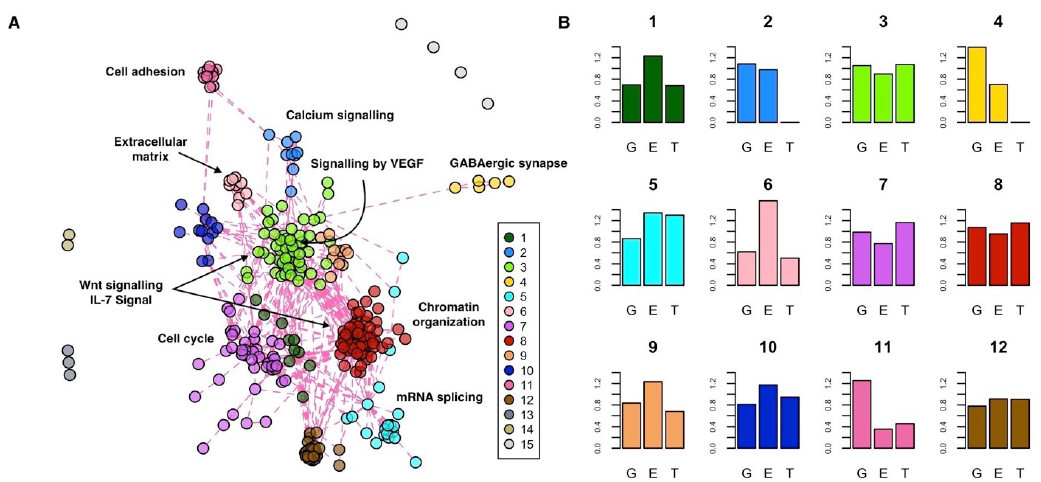
Figure 4. Functional characterization of the INT-MODULE. ( A ) Topological clusters; #1–12: Clusters of the largest connected component; #13,14: Two clusters of three and two genes, respectively; #15: The remaining four genes. ( B ) Enrichment (vertical axis) of each cluster in terms of genes supported by genomics (G), epigenomics (E), and transcriptomics (T): A value of 1 indicates the same proportion within the cluster and in the whole INT-MODULE.